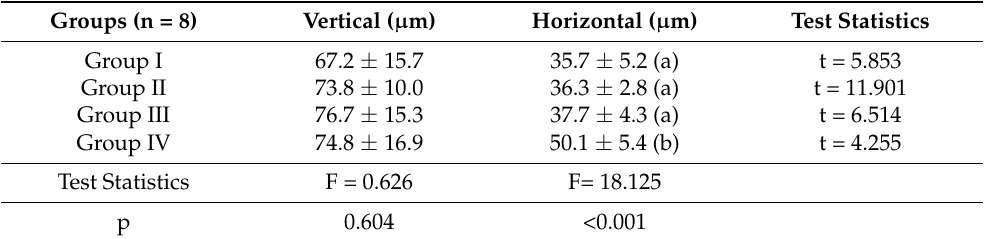
Table 4. Comparison of the mean values of the vertical and horizontal dimensions of the m. pubo- caudalis muscle according to the groups.